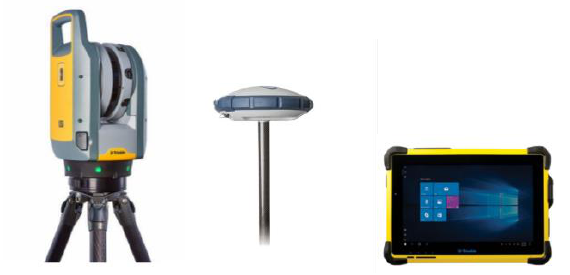
Figute 3. High-speed 3D laser scanning system: a) Trimble X7; b) SP60 GNSS receiver; c) Trimble T10 tablet.